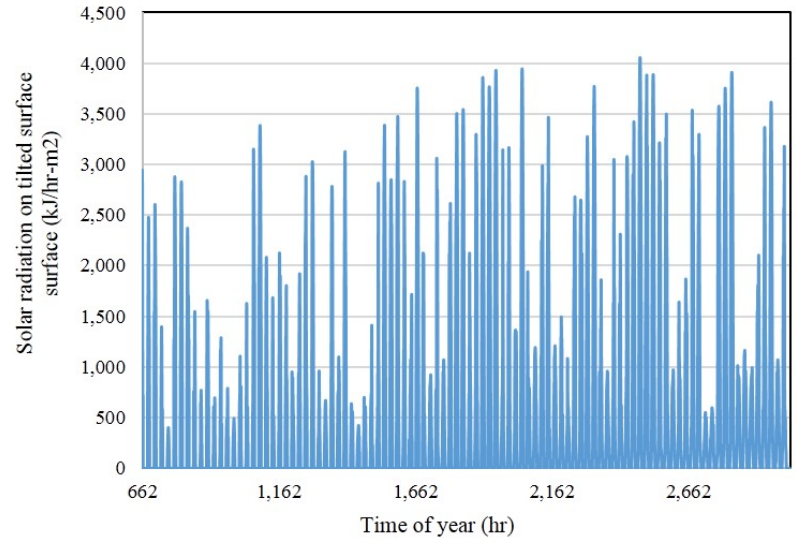
Figure 4. Solar radiation for Anchorage, Alaska for the duration of the experiment.